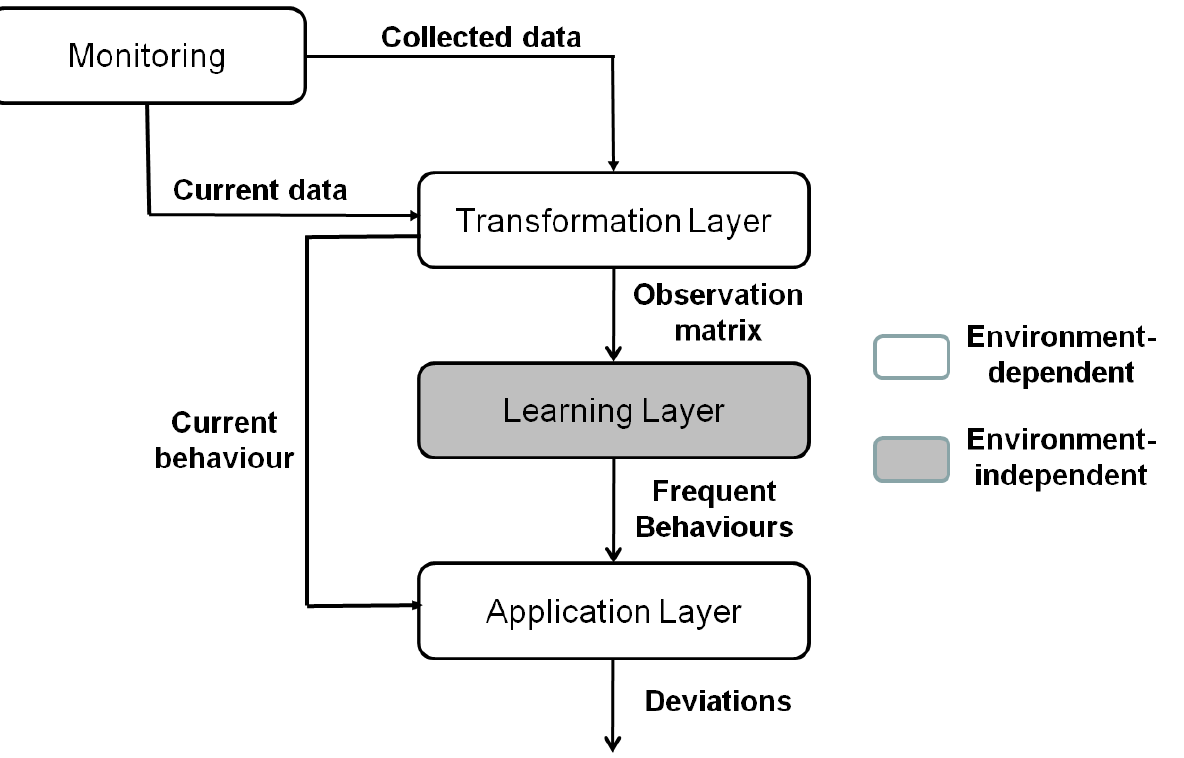
Figure 1. General architecture for identifying